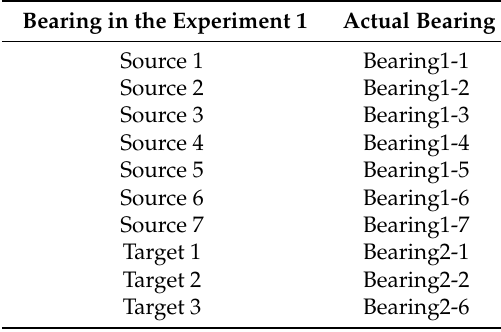
Table 1. Setting of experiment